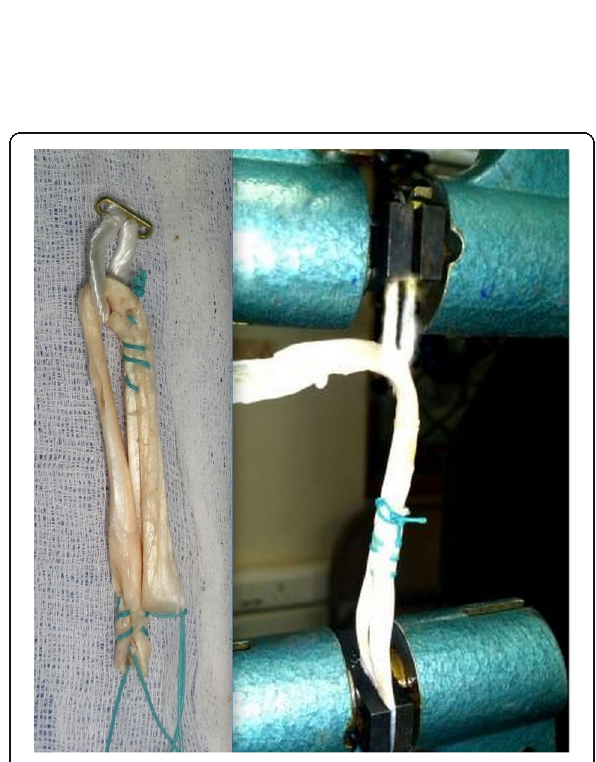
Fig. 8 Failure in Group III, Asymmetric loading and early rupture of tendon. (Representative